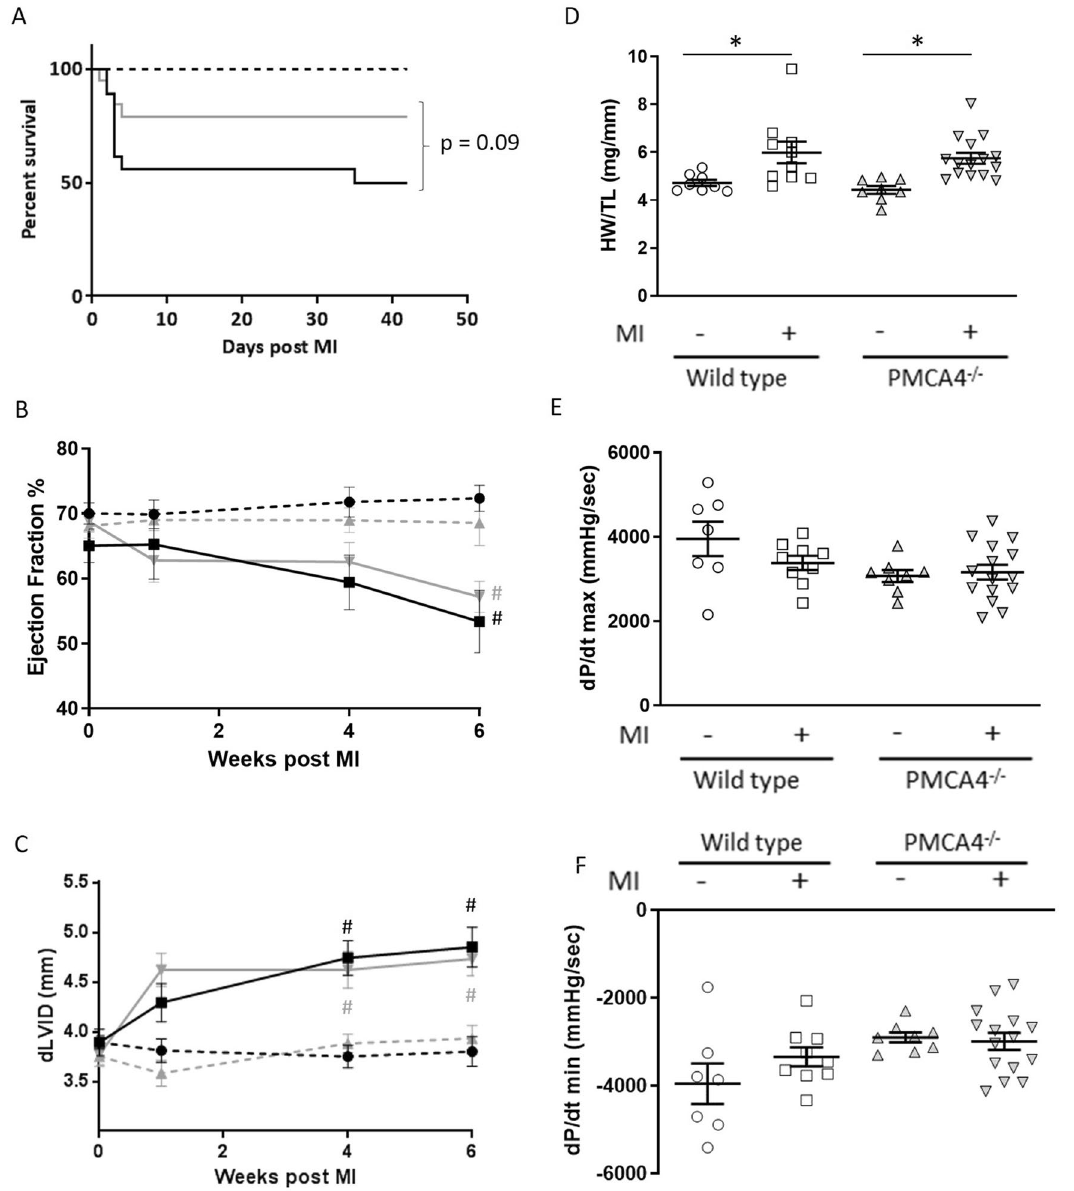
Figure 1. PMCA 4 global deletion does not affect cardiac structure or function post-MI. ( A ) Kaplan–Meier survival plots for wild type (black) and PMCA4 −/− mice (grey) followed for 6 weeks post MI (solid lines) or sham (dashed lines) surgery. Starting populations; WT sham n = 8, WT MI n = 18, PMCA4 −/− sham n = 8, PMCA4 −/− MI n = 19. ( B ) Ejection fraction and ( C ) Diastolic left ventricular diameter tracked for 6 weeks post-MI or sham surgery by echocardiography. # p < 0.05 versus sham control at matched time point ( D ) Heart weight/tibia length ratio 6 weeks post-MI or sham surgery. ( E ) dP/dt max and ( F ) dP/dt min 6 weeks post MI or sham surgery. WT sham n = 8, WT MI n = 9, PMCA4 −/− sham n = 8, PMCA4 −/− MI n = 15 * p <